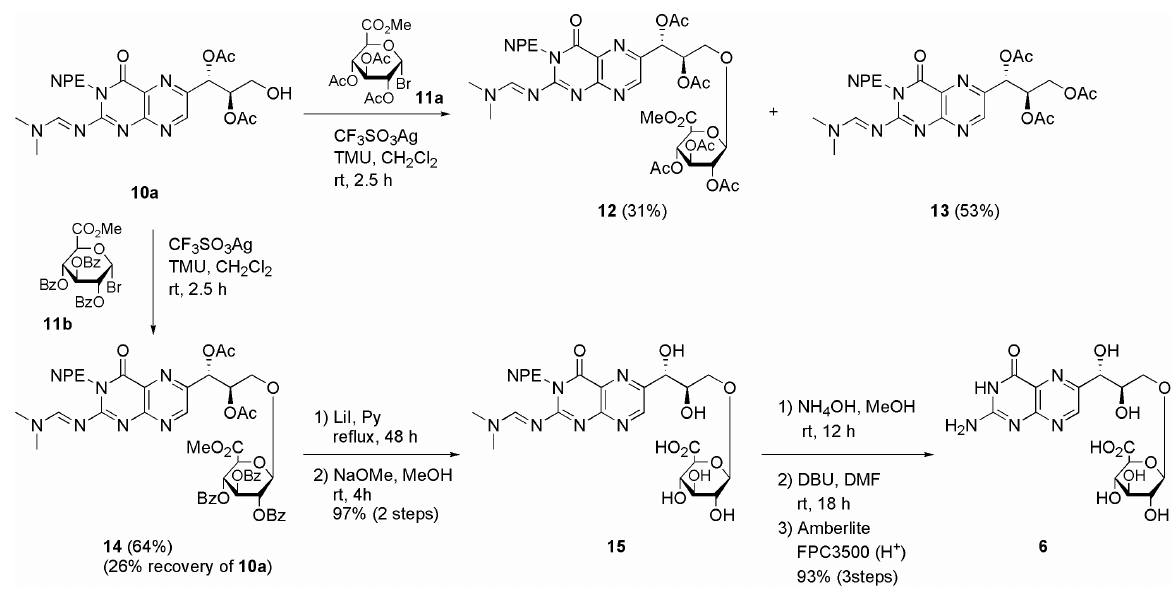
Figure 3: Synthesis of 3'- O -( β -D-glucopyranosyluronic acid)neopterin (6)